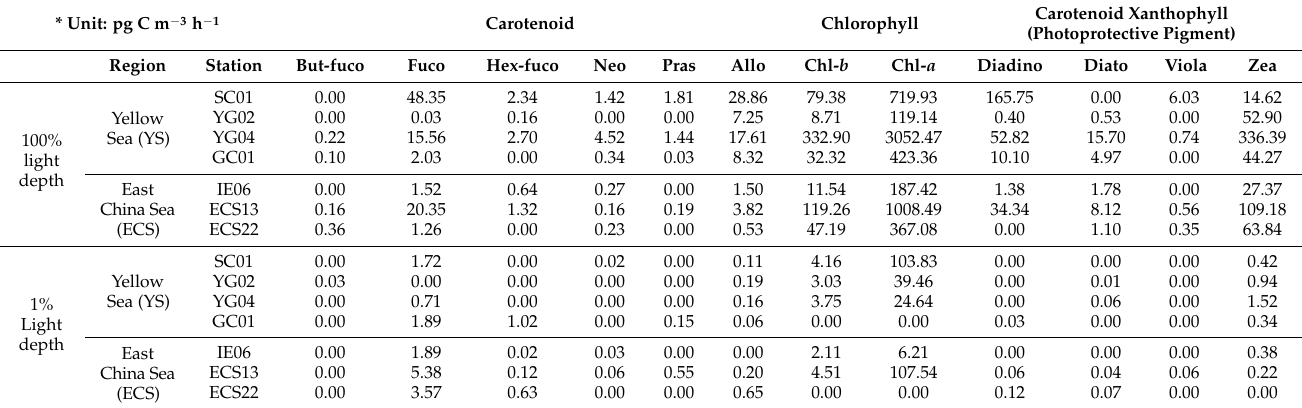
Table 2. Pigment production rates at 100% and 1% light depths in the study area during late summer of